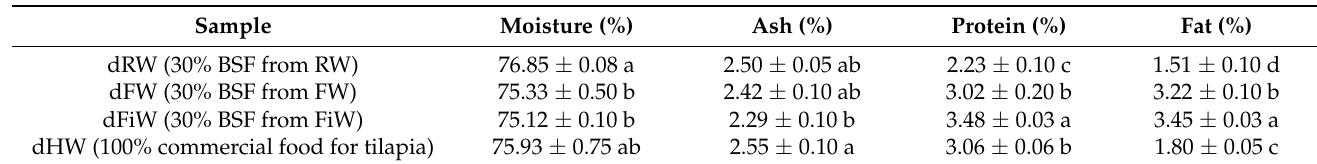
Table 6. Nutritional composition in the muscle of O. niloticus fed with diets based on 30% flour from the black soldier